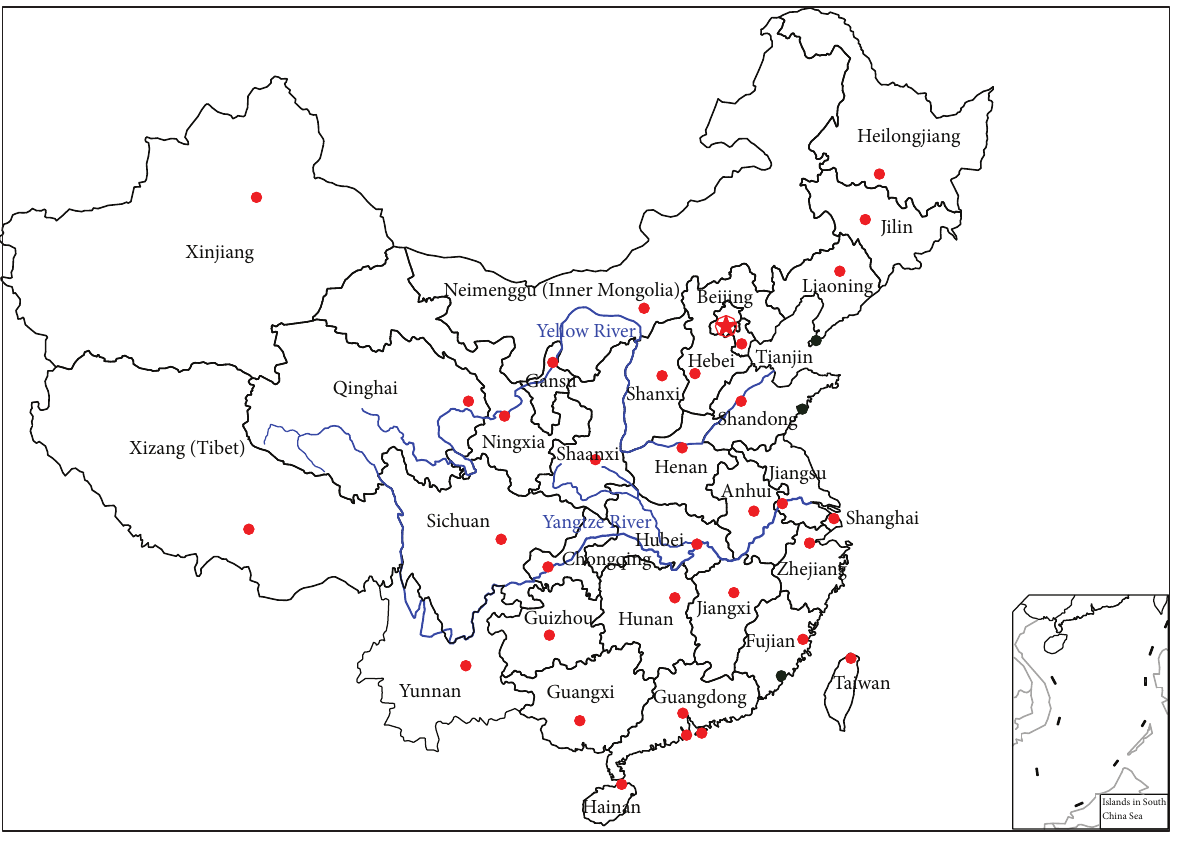
Figure 1: A sketch map of 31 regions including the 27 provinces, autonomous regions, and 4 municipalities directly under the Central Government of